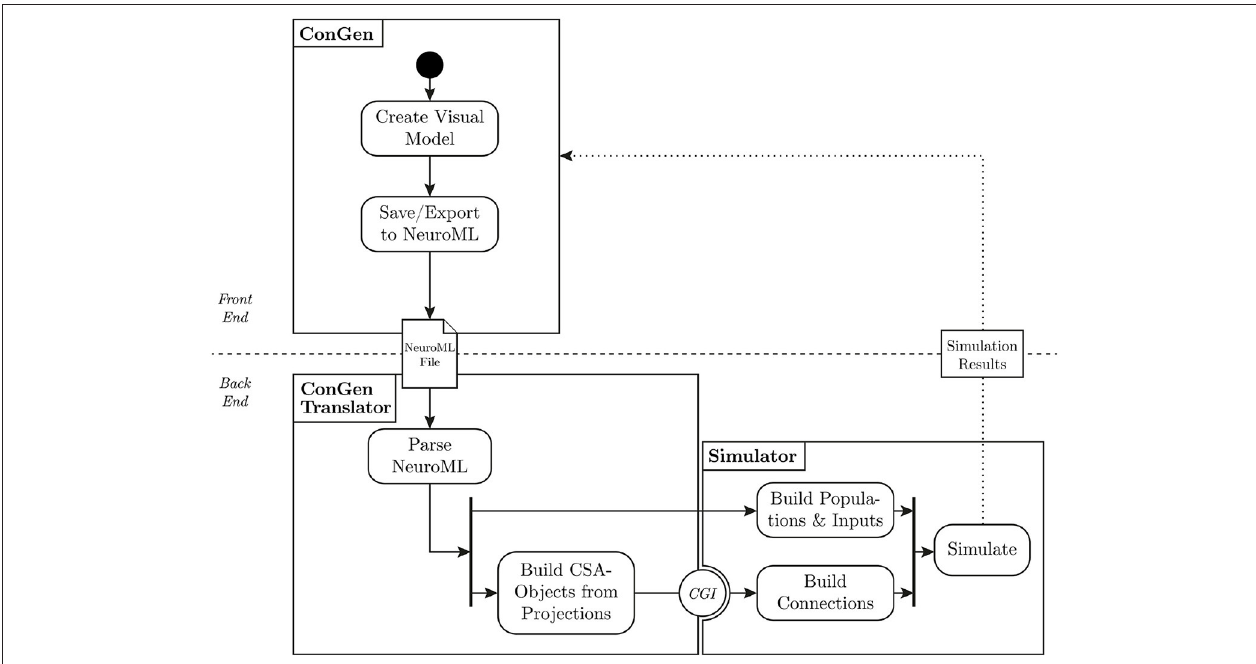
FIGURE 5 | Flow of data from visual representation to simulation. The user creates a model in ConGen and exports it as a NeuroML file. The translator parses the NeuroML file and converts the connectivity into the Connection Set Algebra. The populations and inputs are built directly in the simulator. Using the Connection Generation Interface (CGI), connections are generated from the connection generation library and passed to the simulator, which can then start the simulation. A future extension of this workflow will allow simulation results to be processed and passed back to ConGen (dotted line).